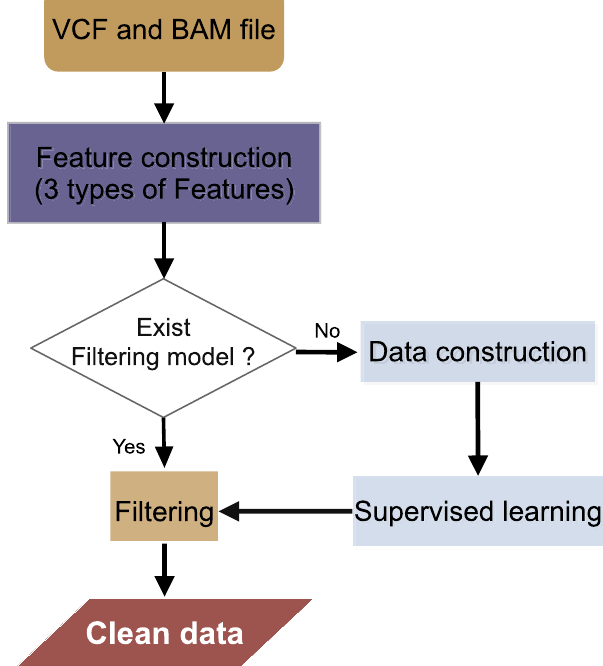
Fig. 1 Work fl ow of FVC. Taking the VCF and BAM fi les as input, FVC uses the feature construction module to build three types of features related to sequence content, sequencing experiment, and bioinformatic analysis process. If a pre-trained model is already built for the speci fi c pipeline, the variants can be immediately classi fi ed as true or false using the fi ltering module. Otherwise, the pre-trained model can be built using the data construction and supervised learning modules of